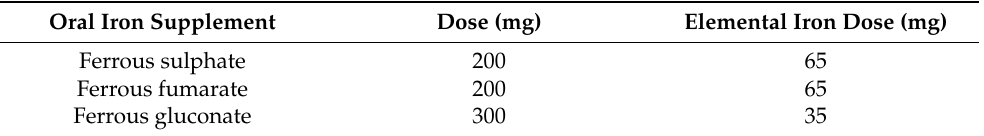
Table 1. The three most common oral iron supplements used for the treatment of iron defi- ciency